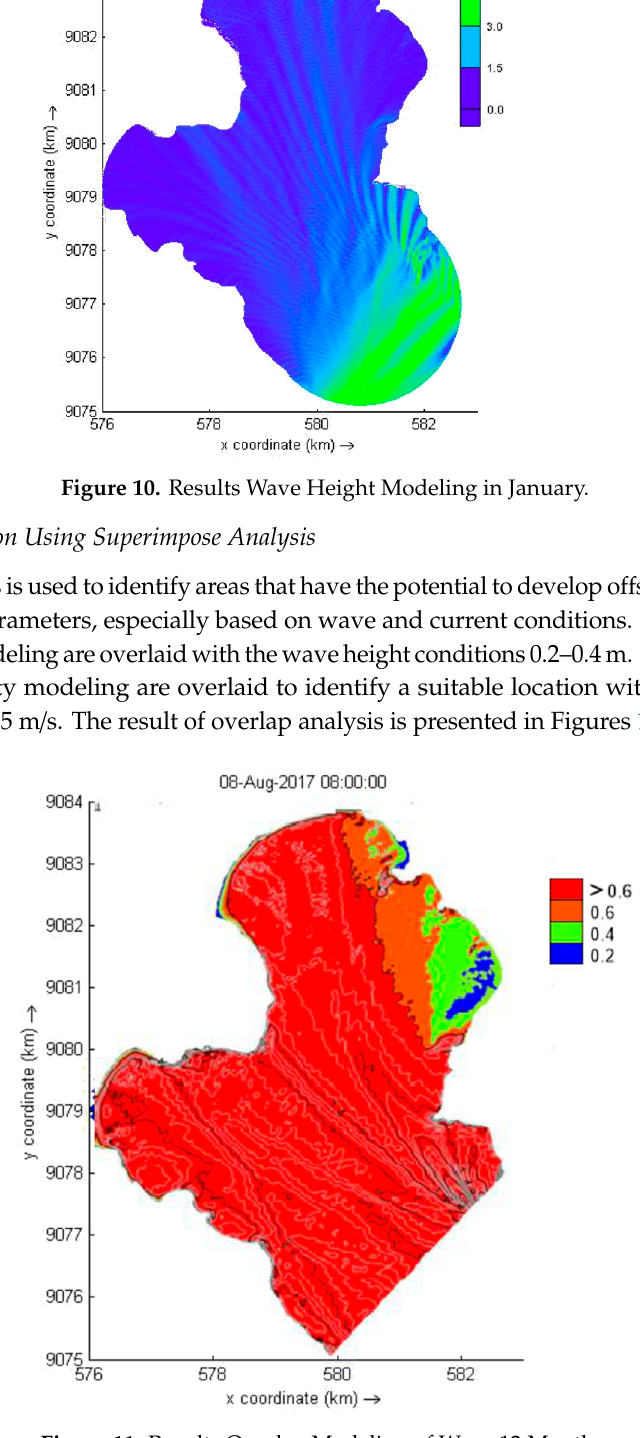
Figure 12. Current Modeling Overlay Results.